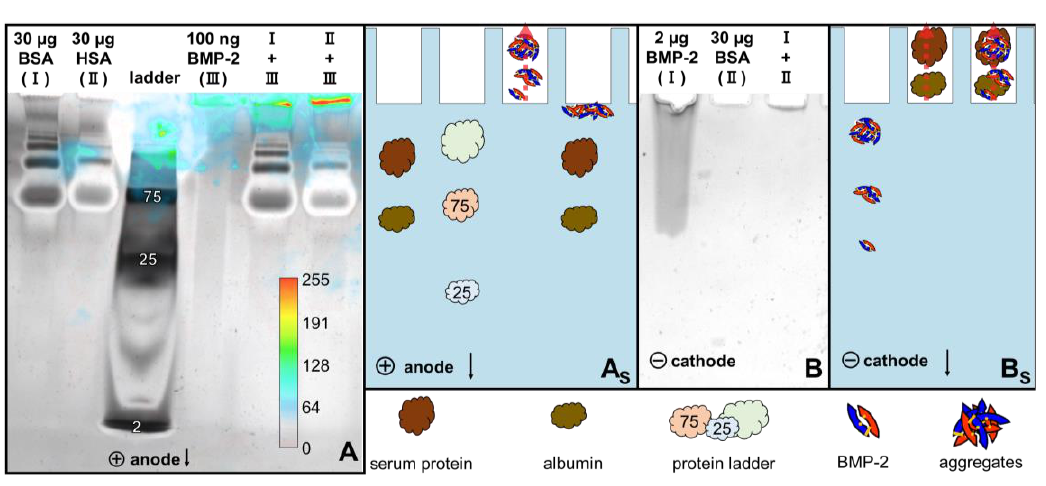
Figure 6. ( A ) Silver staining and overlay of luminescence intensity after Western blot of identical gel, after anodic native PAGE at pH 8.3, ( A S ): explanatory illustration of ( A ), ( B ) silver staining after cathodic native PAGE at pH 7.6, ( B S ): explanatory illustration of ( B ). Red arrows illustrate the apparent direction of movement.